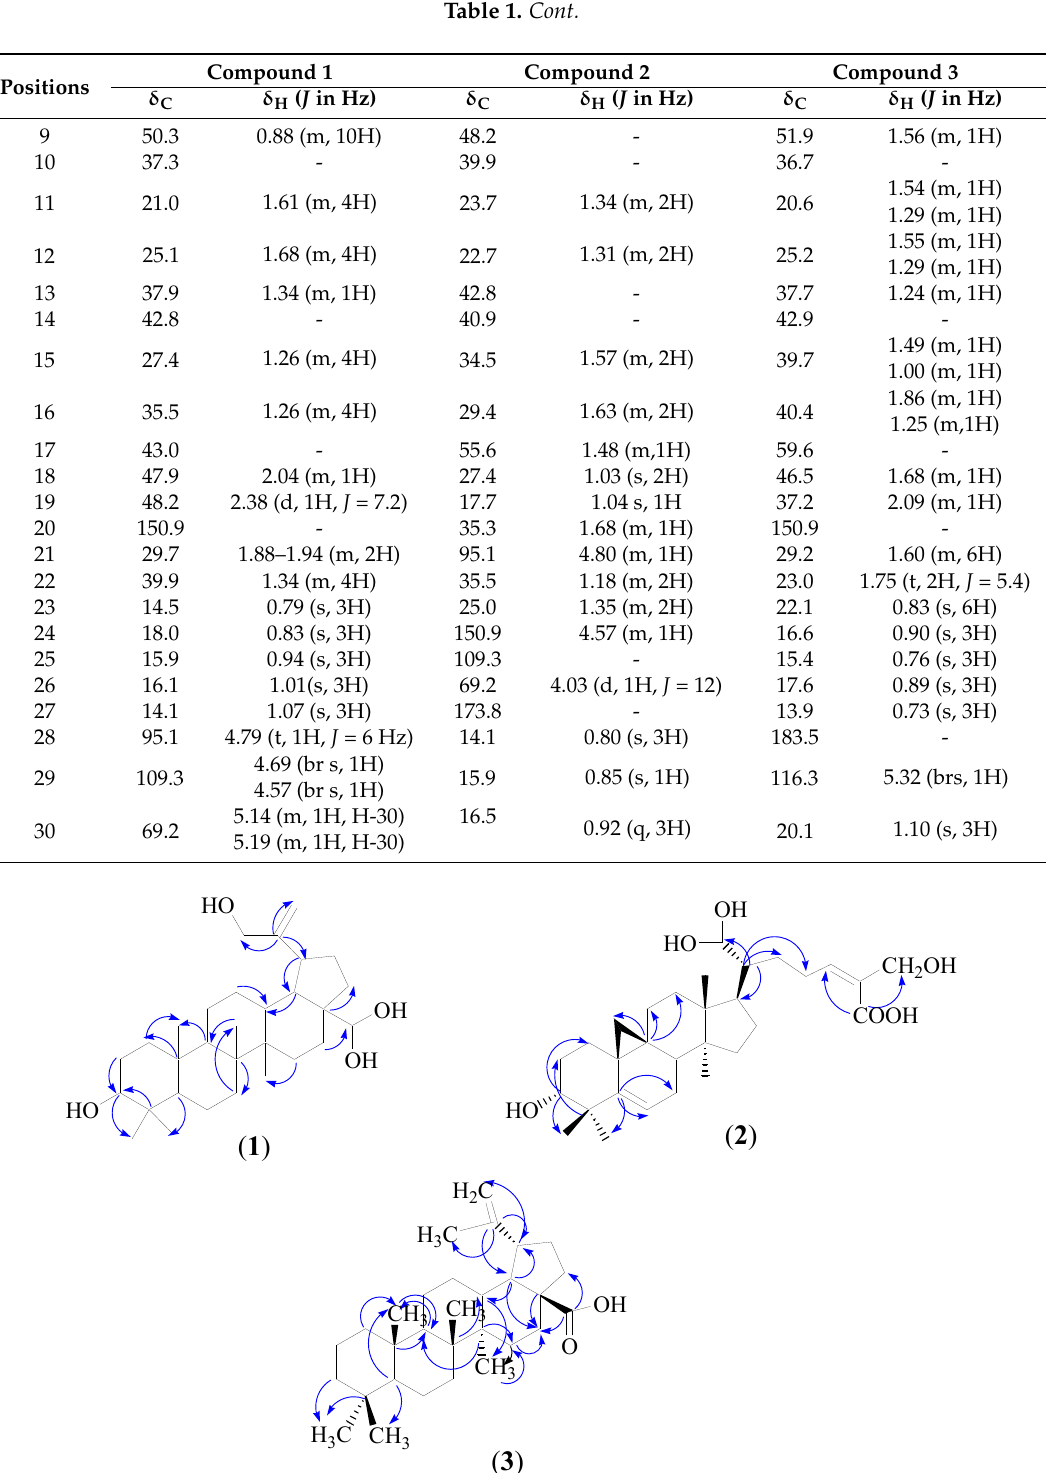
Figure 2. Selected HMBC correlations (C → H) of compounds 1 – 3 .